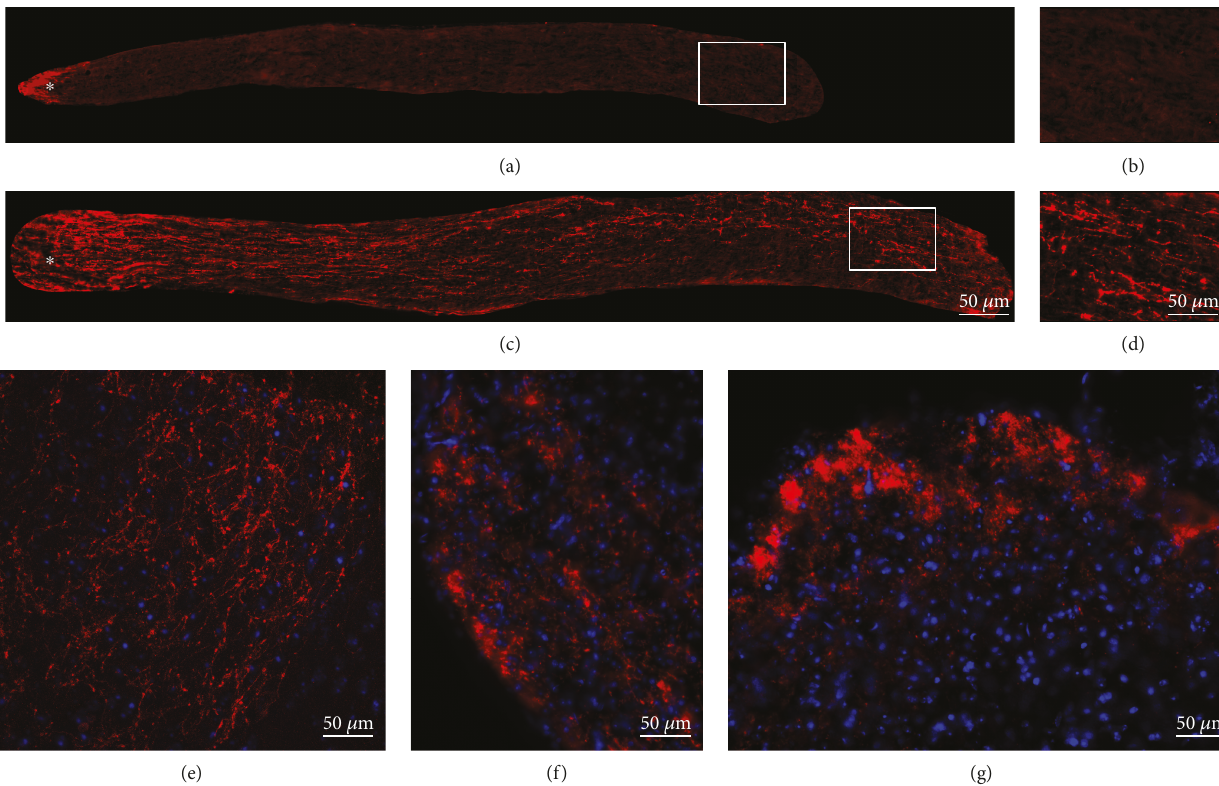
Figure 1: Optic nerve regeneration. (a – d) CTB labeling (red) and nuclear staining (blue) two weeks after optic nerve injury; (a and b) optic nerve from the Crush-only group exhibiting no CTB + axons (red) beyond injury site; (c and d) optic nerve from the Regenerating group showing full-length axon regeneration; (e – g) CTB (red) and nuclear labeling (blue) showing di ff erent levels of reinnervation of the visual nuclei twelve weeks after optic nerve injury. (e) CTB + axons at the suprachiasmatic nucleus; (f) CTB + fi bers at the lateral geniculate nucleus; (g) CTB + axons at the superior colliculus. N = 5 per group. (a – g) Scale bars: 50 μ